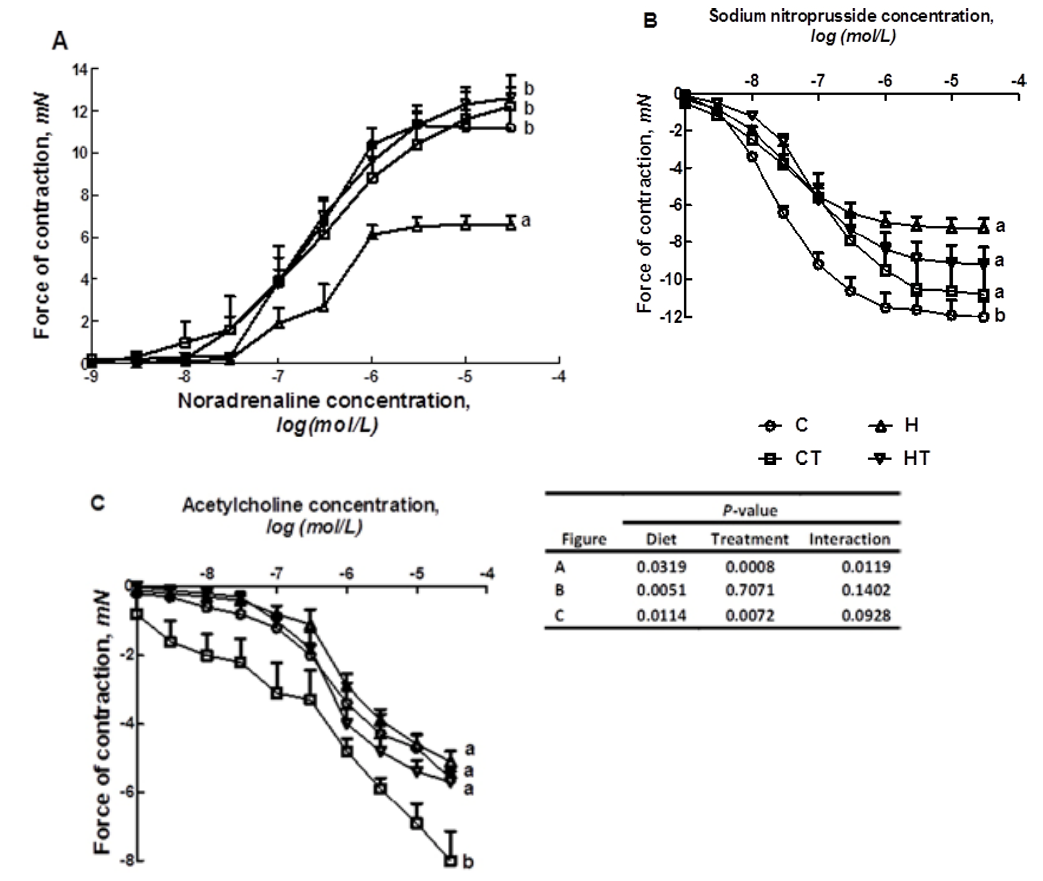
Figure 2. Cumulative concentration-response curves for noradrenaline ( A ), sodium nitroprusside ( B ) and acetylcholine ( C ) in thoracic aortic rings from C, CT, H and HT-diet fed rats. Data shown as means ± SEM. Endpoint means with different letters in each data set significantly differ. n =